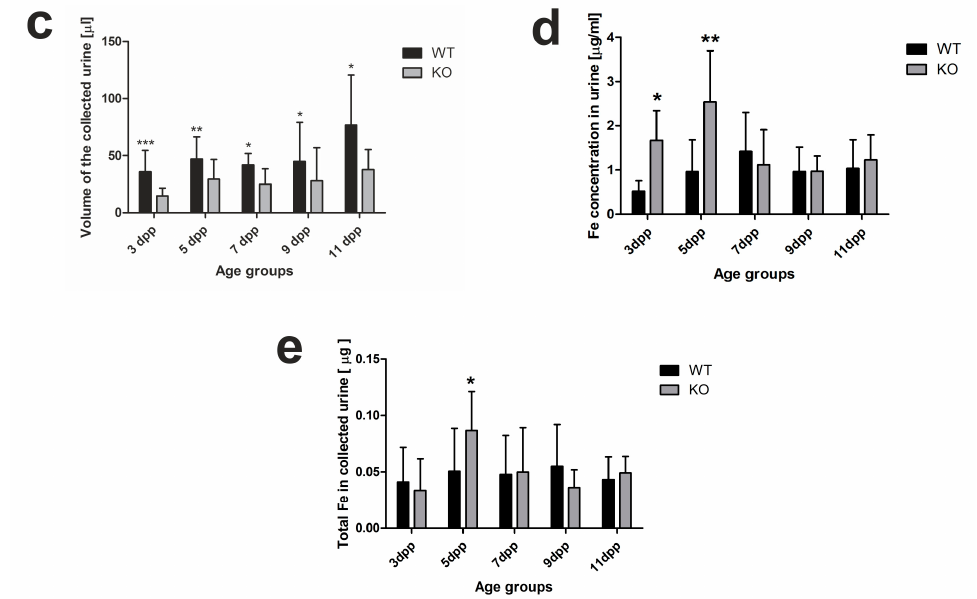
Figure 2. Kidney structure and urine analyses. ( a , b ) Hematoxylin–eosin staining of kidney sections from 5 and 11 day old (WT) and heme oxygenase 1 (HO1) knockout (KO) neonates; 20 × magnification (upper panels) or 40 × magnification (bottom panels). Scale bars correspond to 100 µ m in 20 × magnification and 50 µ m in 40 × magnification. ( c ) Iron concentration measured by AAS (atomic absorption spectroscopy) in urine samples of the WT and KO neonates from all age groups: n = 6 for WT 3 dpp, n = 10 for WT 5 dpp, n = 10 for WT 7 dpp, n = 5 for WT 9 dpp, n = 6 for WT 11 dpp, n = 5 for KO 3 dpp, n = 9 for KO 5 dpp, n = 5 for KO 7 dpp, n = 5 for KO 9 dpp, and n = 5 for KO 11 dpp. To compare di ff erences in urine iron concentration between WT and KO groups at each time point, Student t -tests were used for all datasets. ( d ) Urine volume collected from urinary bladder of mice after dissection: n = 16 for WT 3 dpp, n = 19 for WT 5 dpp, n = 8 for WT 7 dpp, n = 12 for WT 9 dpp, n = 14 for WT 11 dpp, n = 14 for KO 3 dpp, n = 18 for KO 5 dpp, n = 7 for KO 7 dpp, n = 9 for KO 9 dpp, and n = 9 for KO 11 dpp.